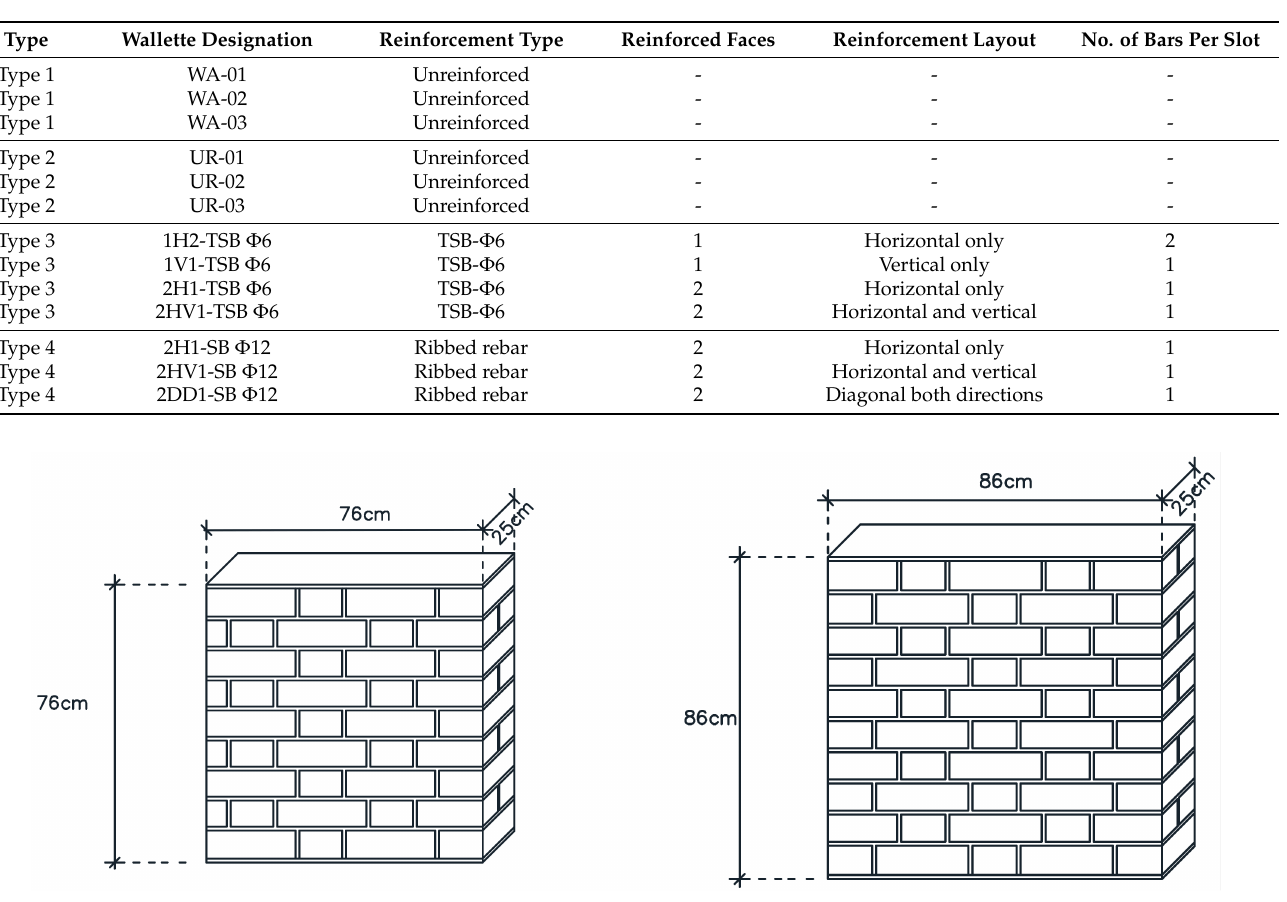
Figure 2. Unreinforced masonry wallette (( left ) Type 1; ( right ) Types 2 to